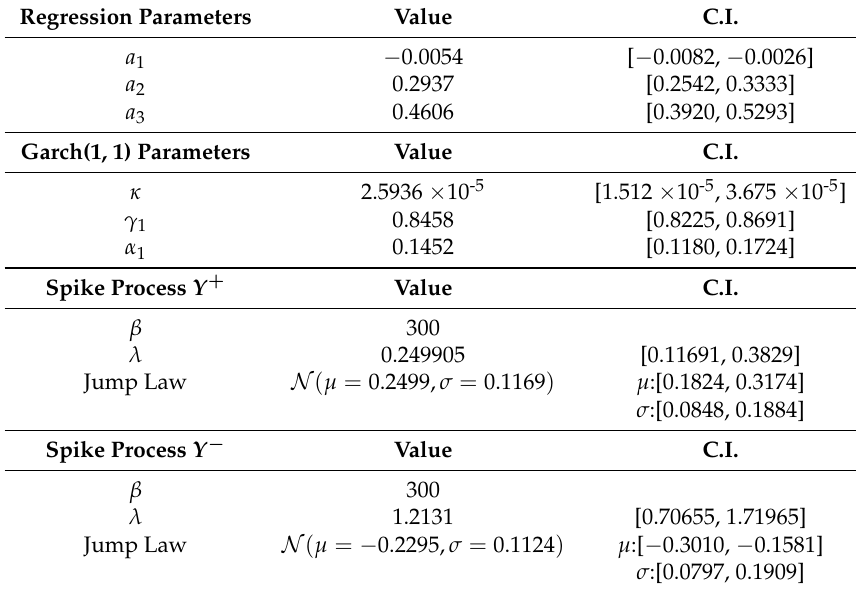
Table 3. Parameter estimates and 95% confidence intervals for Spot model 1, using data from 1997 to